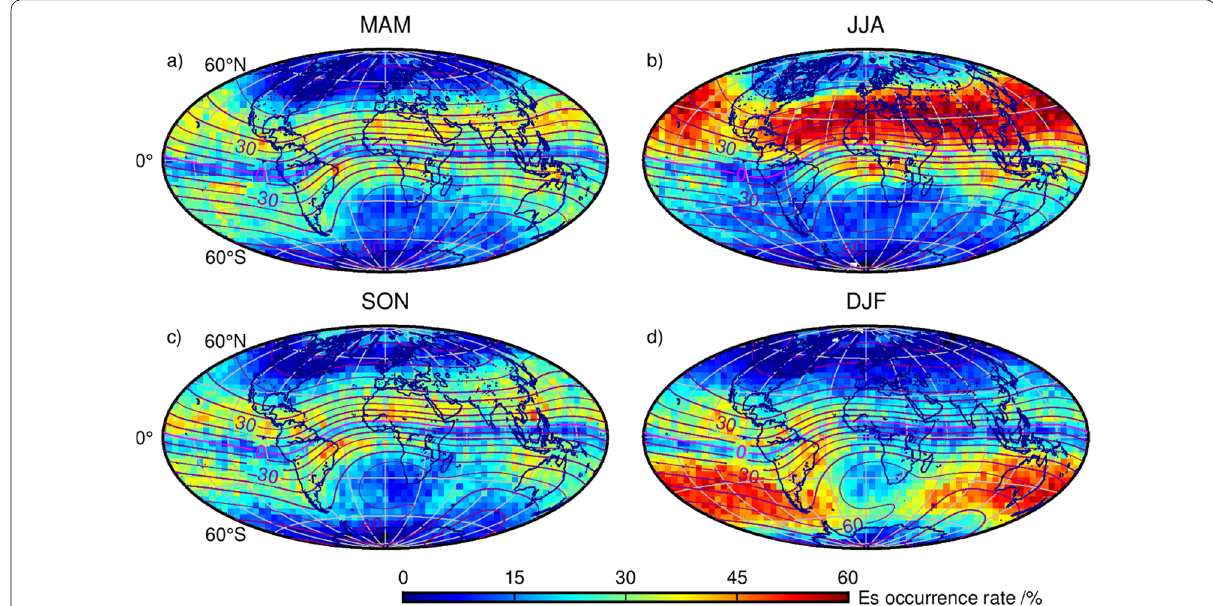
Fig. 10 Seasonal variation in the horizontal distributions of COSMIC RO-derived Es occurrence rates during Jan 2015 to Dec 2019